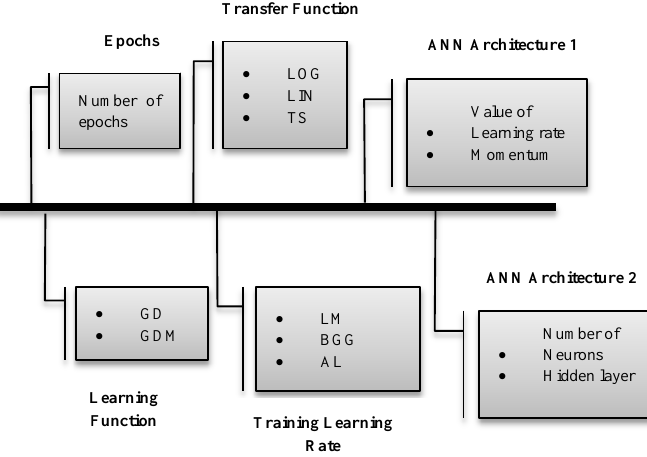
Figure 3. Design parameters of